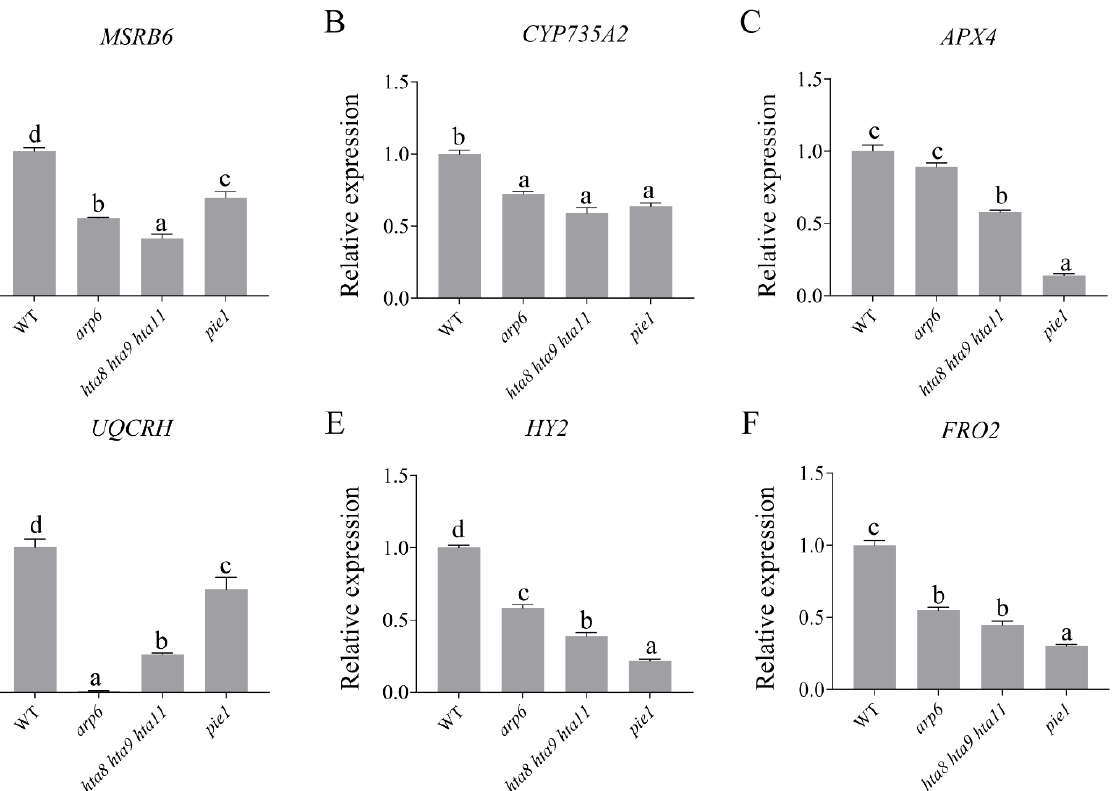
Figure 3. Quantitative real-time PCR expression analysis of six oxidoreductase activity-related genes in the roots of WT, arp6 , hta8 hta9 hta11 , and pie1 : ( A – F ) The expression levels of the six selected genes were obtained by qRT-PCR. The error bars indicate ± SD ( n = 3 replicates). Different letters above the columns indicate significant differences at p < 0.05, as determined by one-way ANOVA.